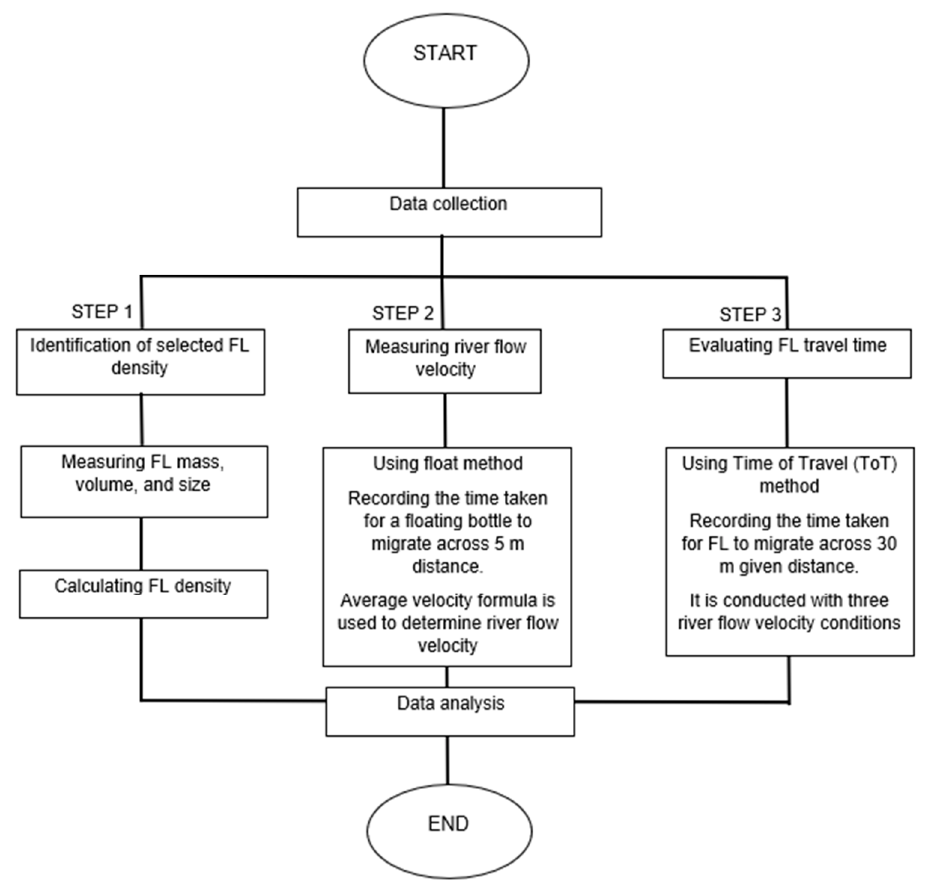
Table 1. The information of the 20 selected objects representing the common FL found in rivers.